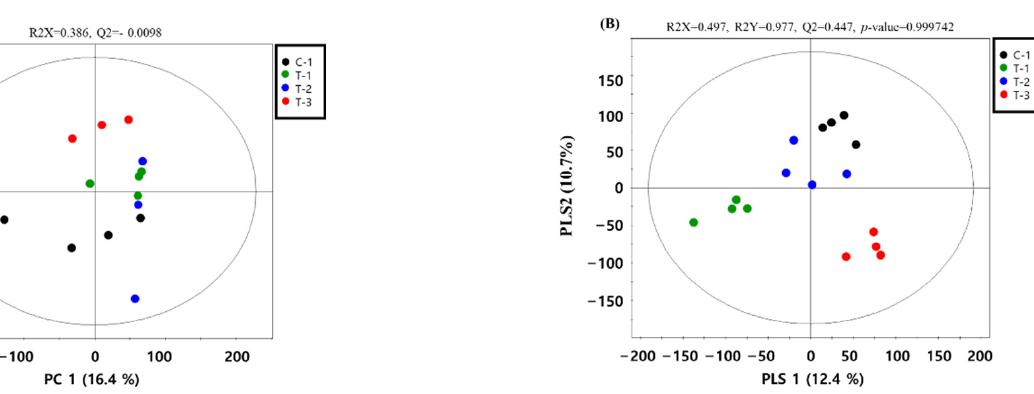
Figure 1. PCA (principal component analysis) score plot of each group in serum ( A ). PLS-DA (partial least squares discriminant analysis) score plot and isolate metabolic parameters (VIP > 0.7) of each group in serum ( B ).